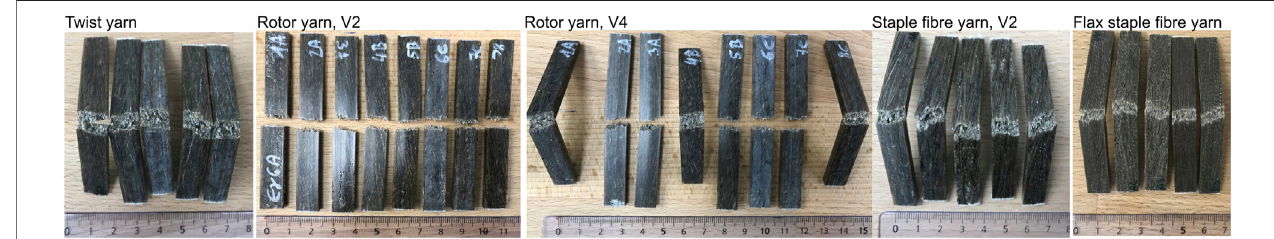
FIGURE 5 | Fracture behaviour after impact tests of pultruded rectangular rods.